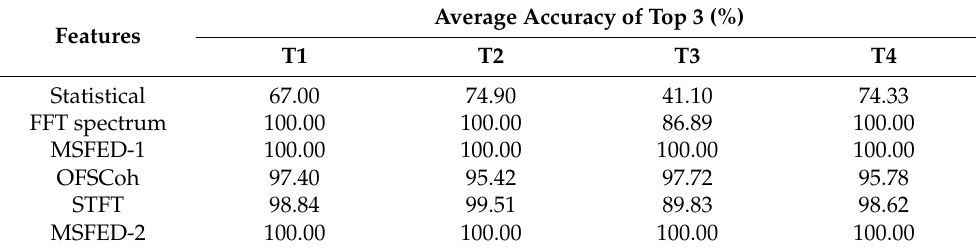
Table 5. The average accuracy of the top-three accuracies.